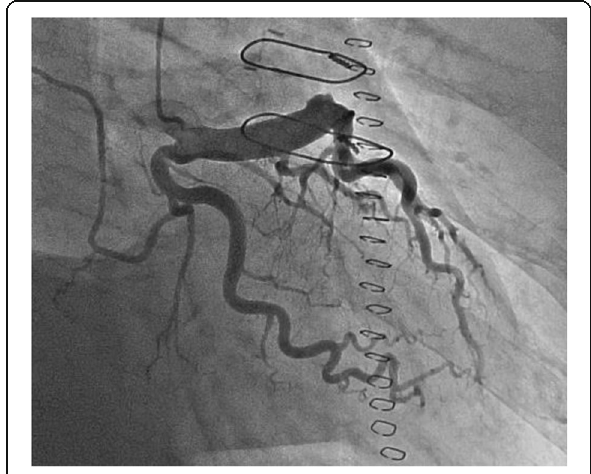
Fig. 4 Postoperative images. Coronary angiography revealed significant ectasia from the left main trunk to the left anterior descending coronary artery. However, there was no aneurysm or